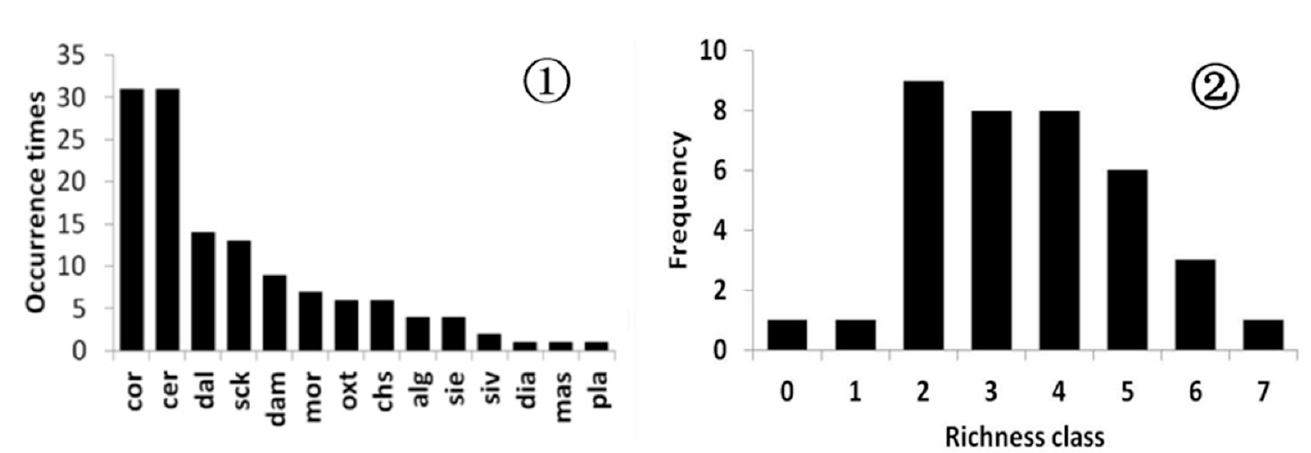
Figure 2. 1 (cid:13) Frequency of each species for all ponds; 2 (cid:13) Bar plot of cladoceran species richness ranks. Abbreviations codes of each species, see Appendix